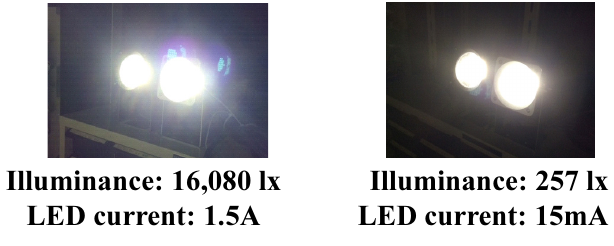
is changed from 15 mA to 1.5 A. LED